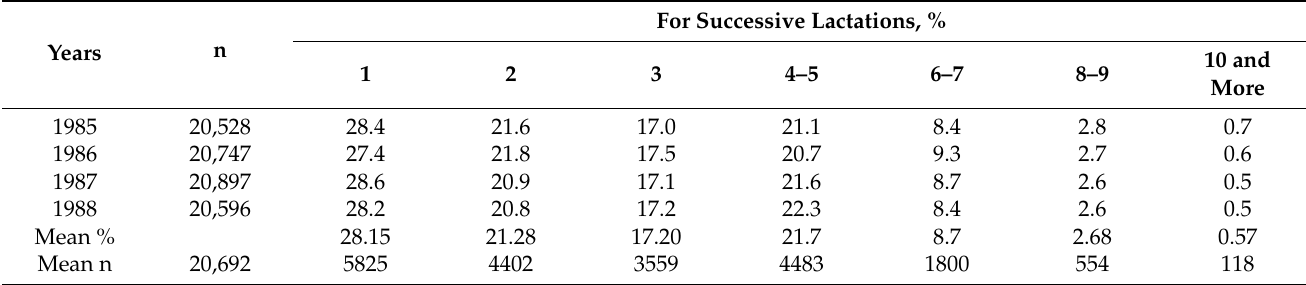
Table 1. Age composition of the dairy herd (Tosnensky district of Leningrad